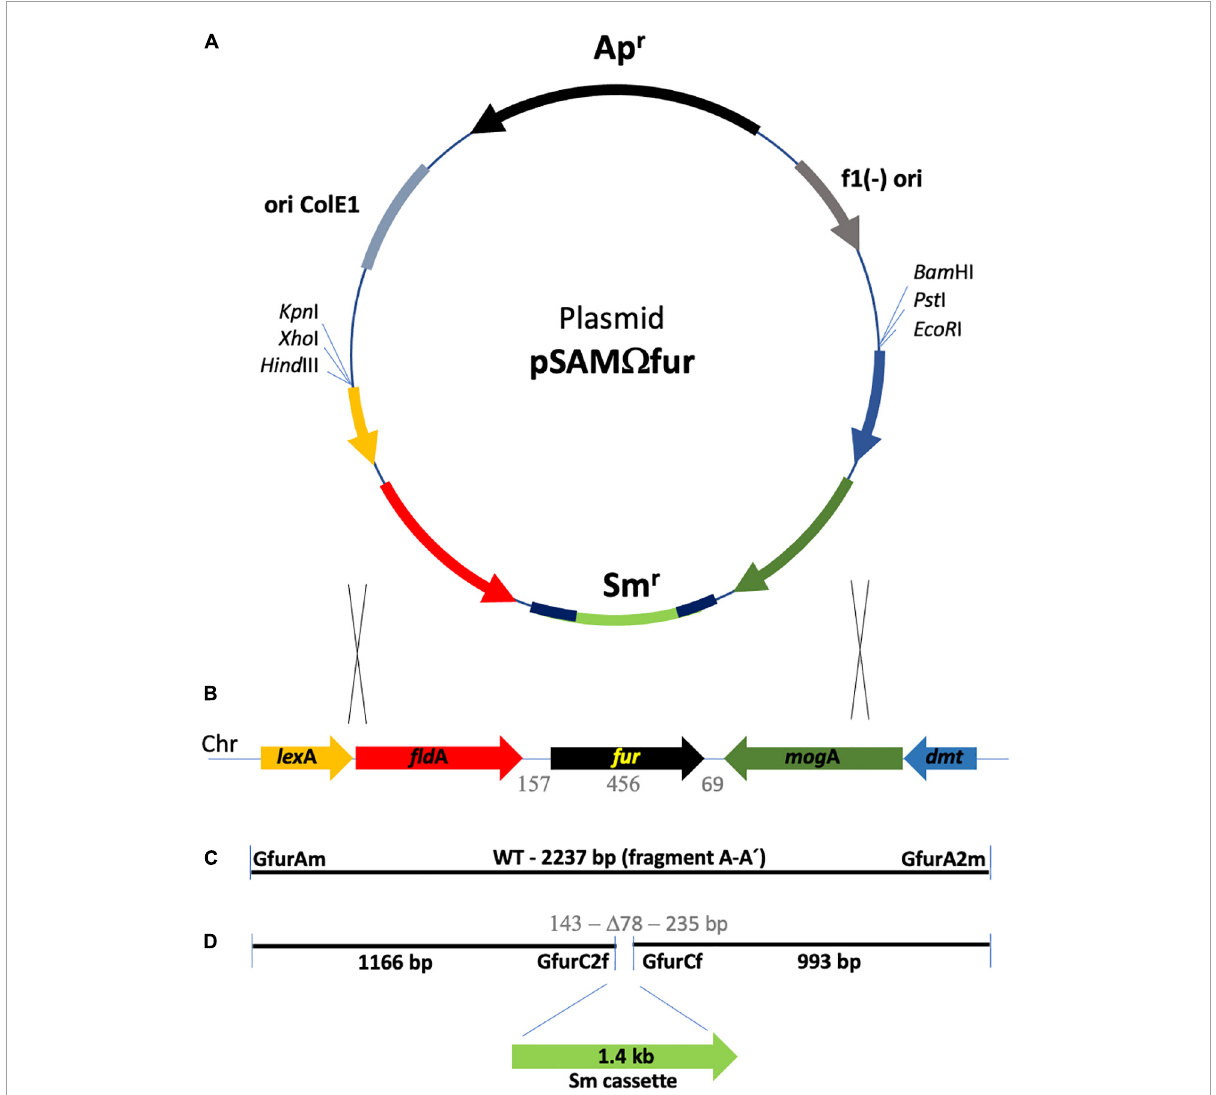
FIGURE1 Schematic representation of the fur locus in the G. anatis 12656-12 genome and strategy of its disruption. (A) Diagram of plasmid pSAM (cid:127) fur, the one-step disruption cassette contains a streptomycin resistance gene flanked by regions of homology shown in red (left) and green (right). (B) Map of the fur locus located on the chromosome of G. anatis 12656-12 ; lexA, fldA, fur, mogA , and dmt are represented as arrows. The genes are homologous to those held in loci UNM179_R10075 to UMN179_R10095 from strain G. anatis UMN179 (accession NC_015460.1). (C) The A-A’ fragment is a PCR amplification product of 2,237 bp, using GfurAm and GfurA2m primers. The gray numbers indicate the size in base pairs of fur and adjacent intergenic sequences. (D) The sequences flanking the deletion site at the fur locus are 1,166 and 993 bp in size and were ligated to a 1.4 kb streptomycin cassette as part of the plasmid shown in A. pSAM (cid:127) fur is an integration plasmid that contains the col E1 replicon but is unable to replicate in G. anatis ; therefore, resistance to streptomycin will only be possible after integration of the cassette into the chromosome. Replacing the fur WT locus with the one-step disruption cassette is indicated by two pairs of crossed lines; the interrupted A-A’ fragment increases the size of the locus by 1.4 kb. The gray numbers indicate the 78 bp deletion and, on the sides, the size of the remaining fur DNA in the